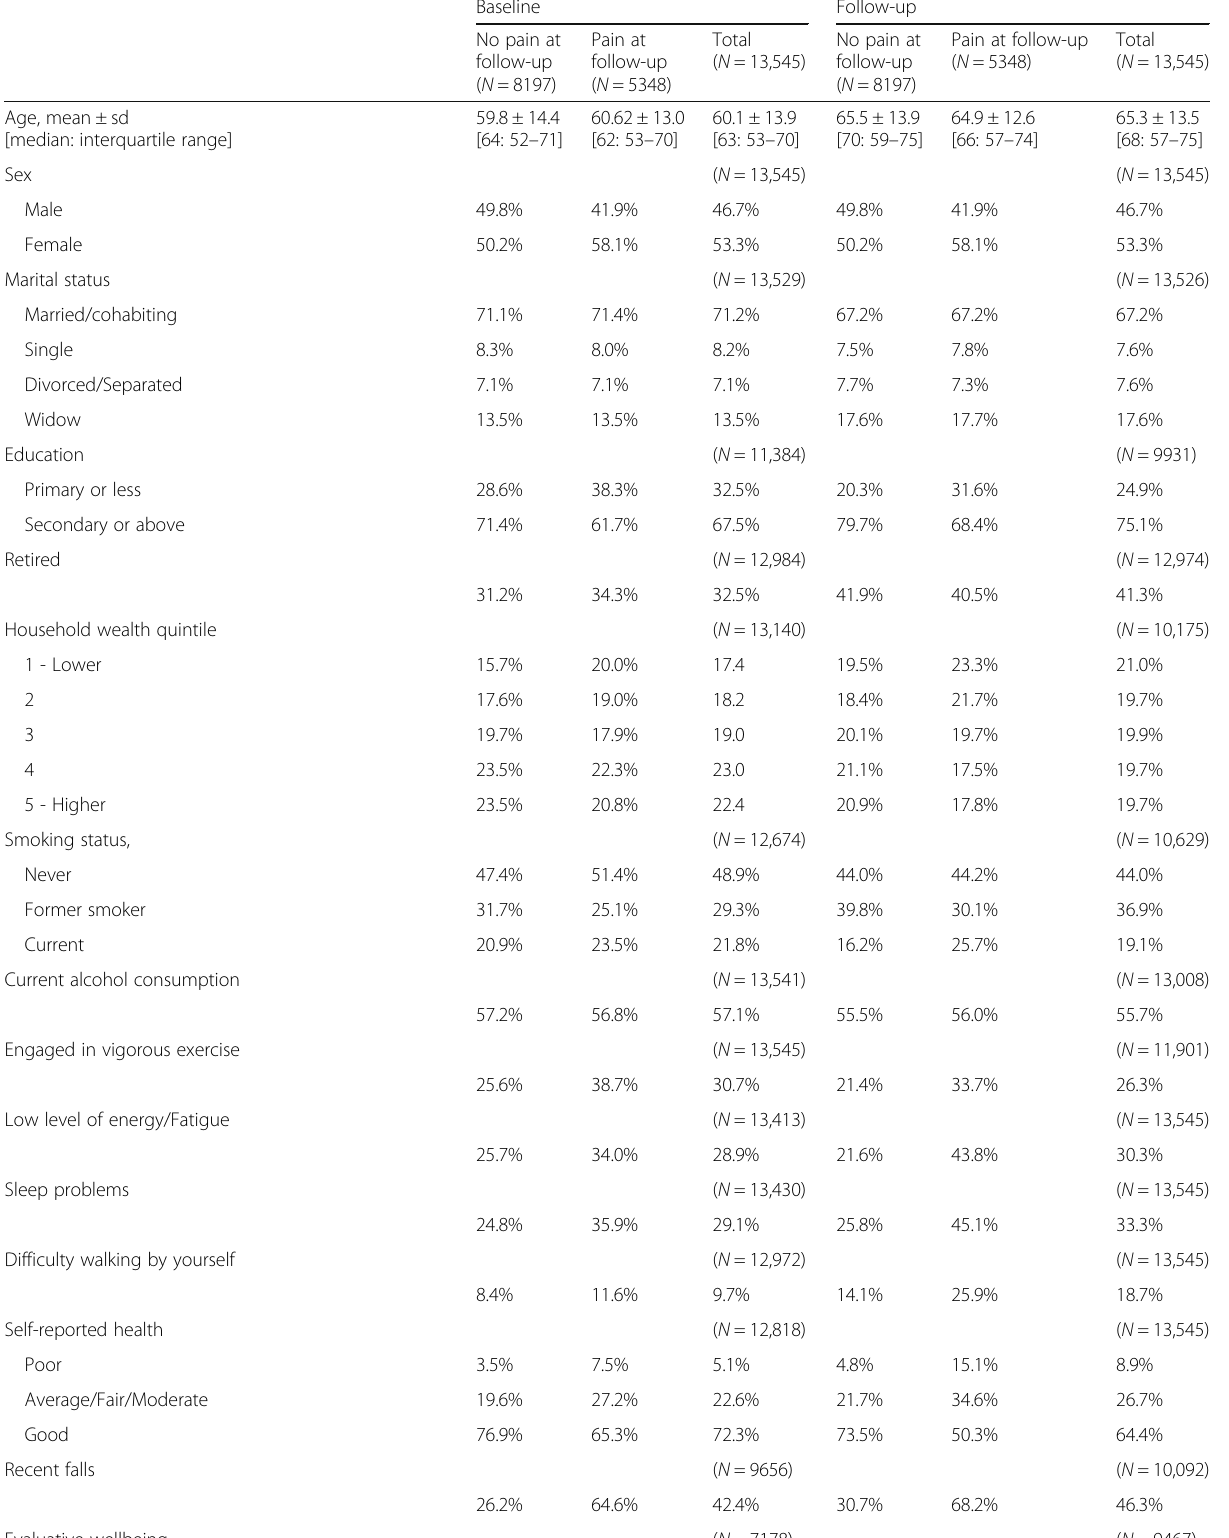
Table 1 Final regression model sample